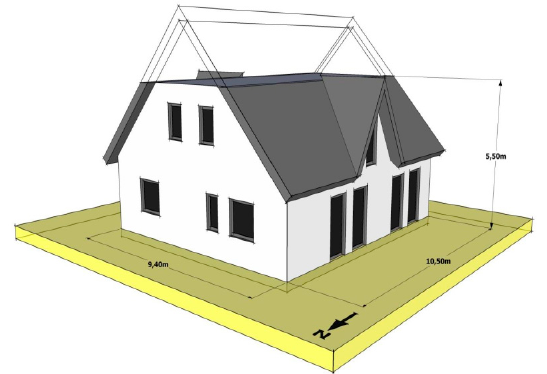
Figure 1. The assessed reference building. Table 1. Assessed building design data.